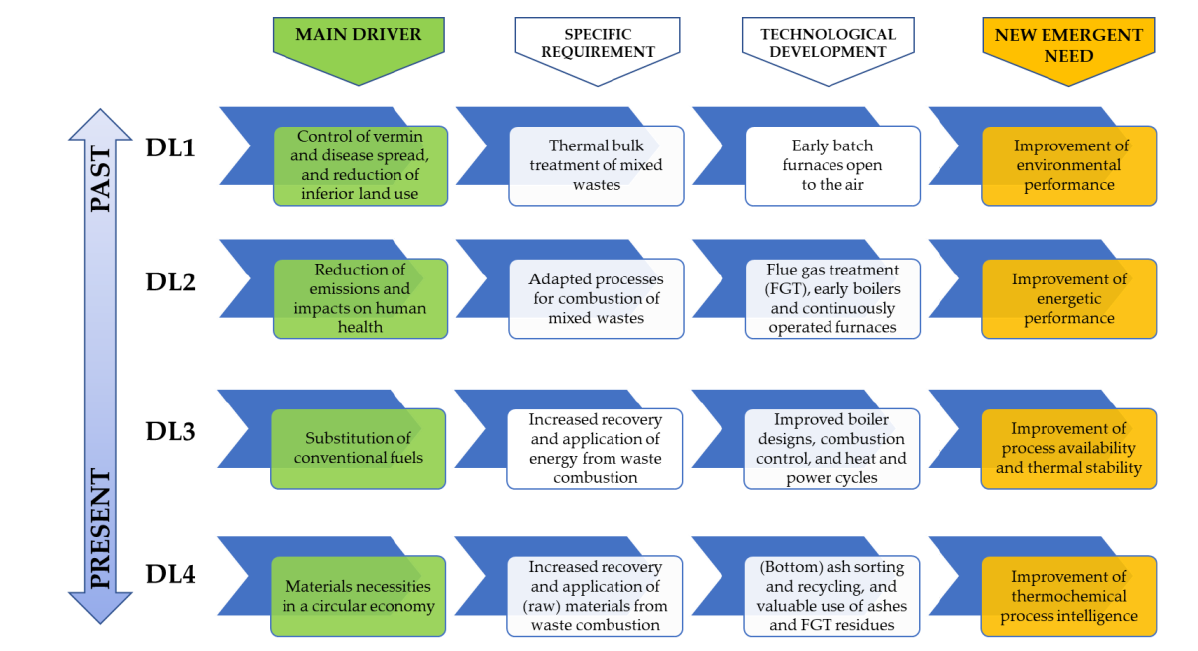
Figure 1. Technological development of waste-to-energy combustion technology, centered around four lines of development as driven by policy (i.e., DL1 to DL4).